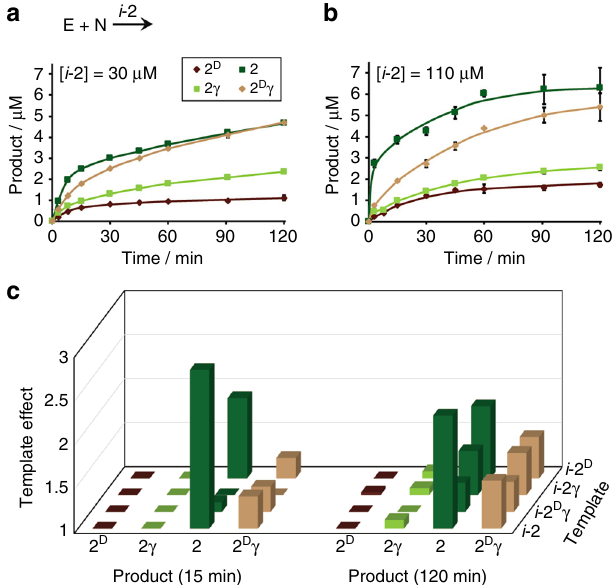
Fig. 6 Template-assisted product formation in reactions between E and N . a , b Time-dependent product formation in reactions seeded with different i - 2 concentrations. c Bar diagram showing the template effect on the four products in the early (15 min) and late (120 min) stages of reactions seeded with 100 ± 10 μ M of each one of the respective templates, separately. Template effect at a particular time is the ratio of product formation in a template-assisted reaction (this fi gure b and Supplementary Fig. 9) to that in the template-free reaction (Fig.